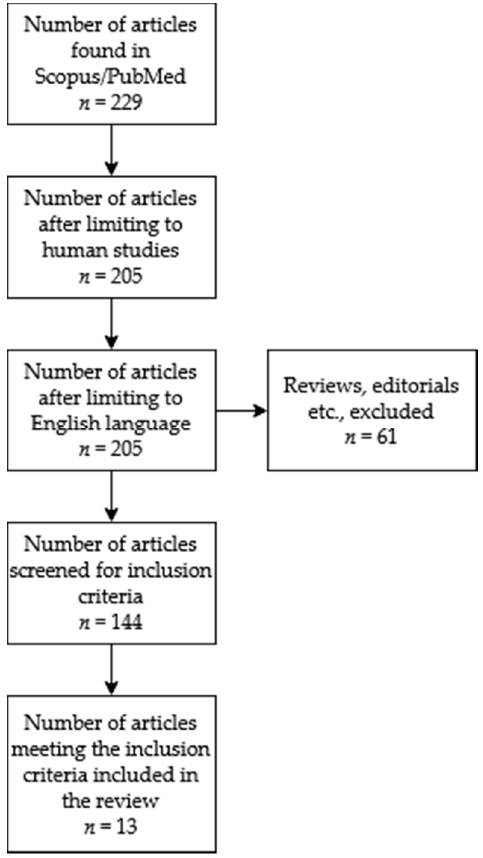
Figure 1. Selection process diagram of articles meeting the eligibility criteria for our review.